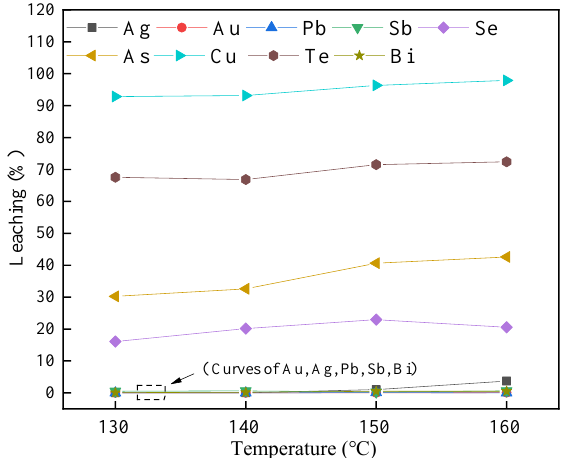
Figure 6. Effect of the temperature on the leaching of each element (t = 2 h, P = 0.8 MPa and H 2 SO 4 = 250 g/L).